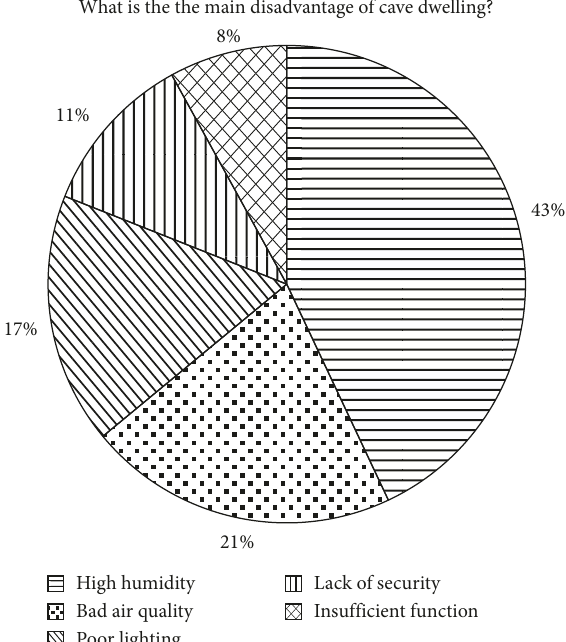
Figure 2: The statistical survey data of indoor humidity of cave